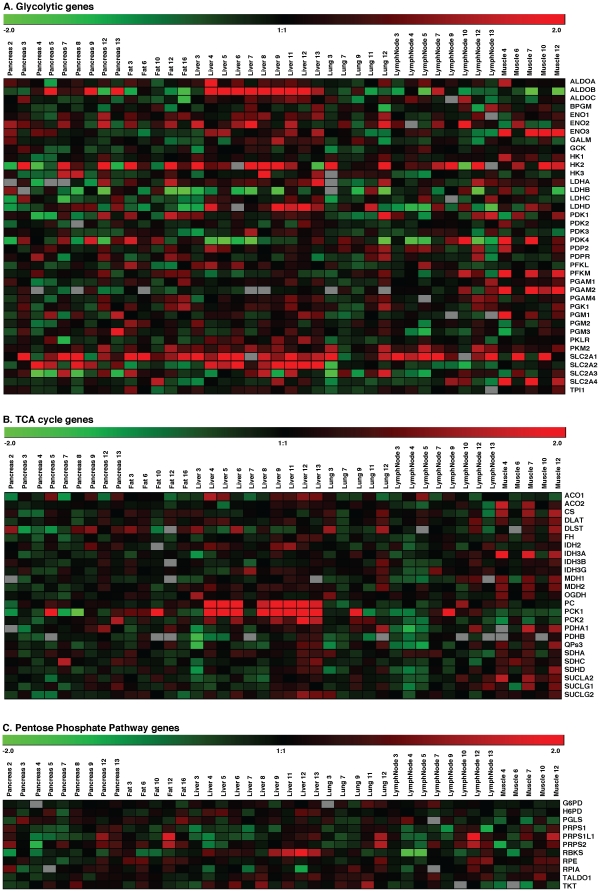
mRNA expression profiles of metabolic genes in primary and metastatic lesions.The mRNA expression profiles from pancreatic cancer patients were analyzed on 80 Agilent human whole genome 4×44 K DNA microarrays. The heatmap was created by Genesis [17]. The heatmap display the mean log2 fold change of the gene intensity between the samples from the metastasis site or the primary pancreatic cancer site and the reference mRNA samples. The genes examined were functionally involved in glycolysis (A), Krebs tricarboxylic acid cycle (B) or pentose phosphate pathways (C).